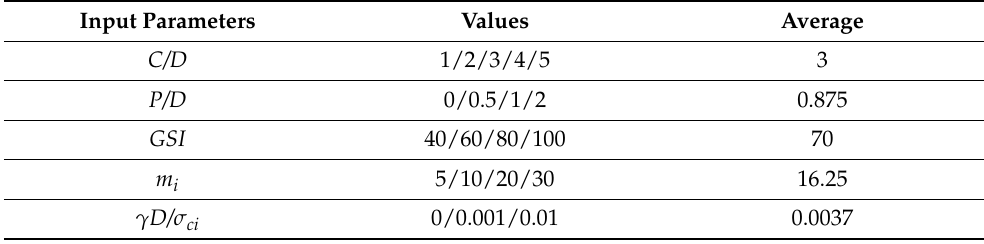
Table 2. Output parameter.